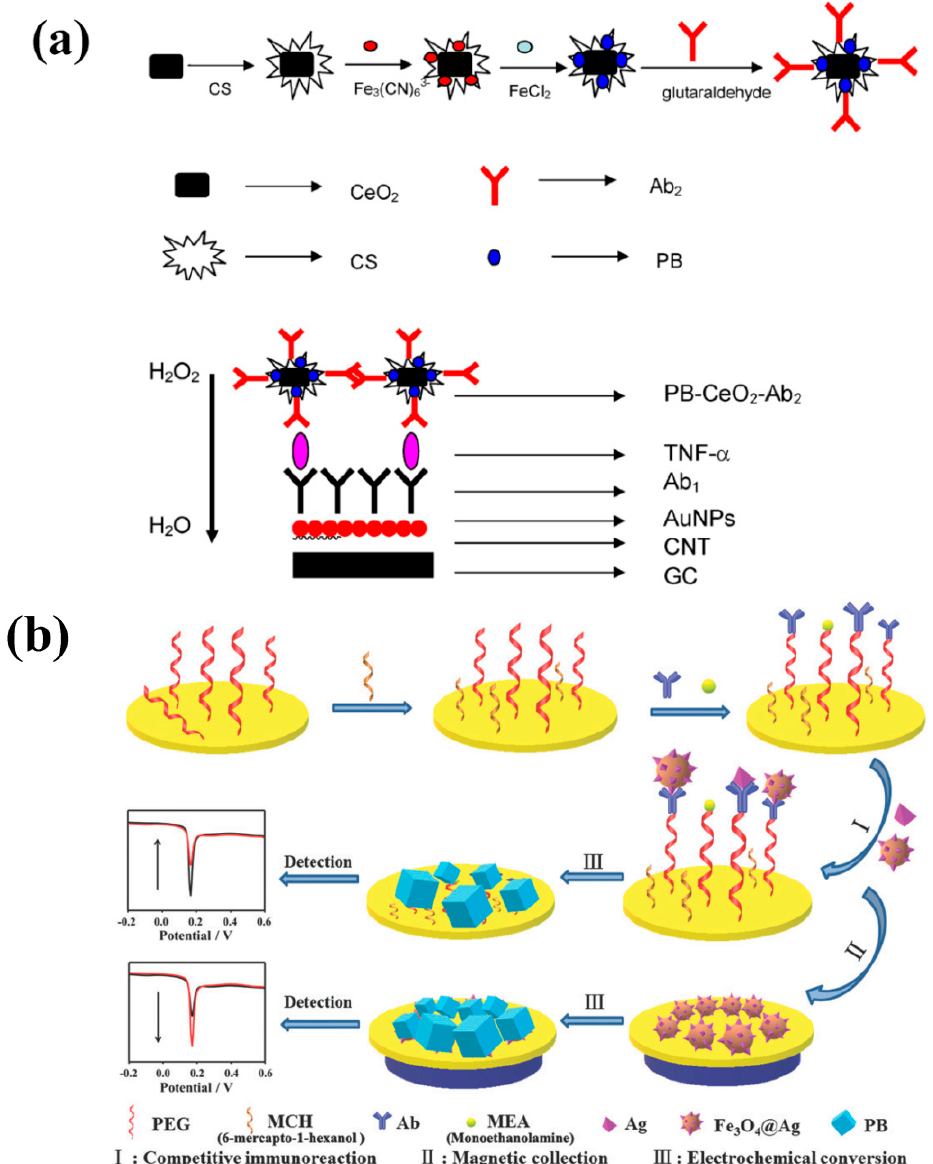
Figure 2. Schematic illustration of the electrochemical immunosensor fabrication process for sandwich format ( a ) and competitive format ( b ), adapted with permission from ref. [21,70].